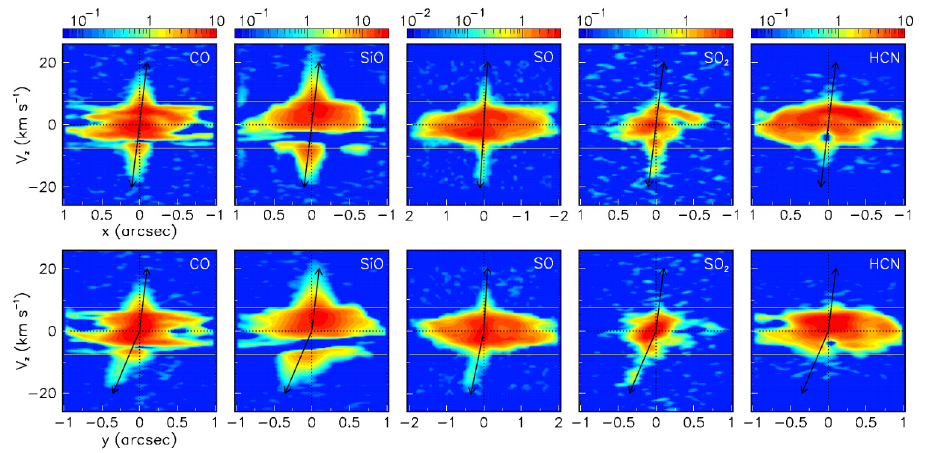
Figure 7 : R Dor: P-V maps in the V z vs x and vs y planes. The colour scale is in units of Jy arcsec − 1 . Yellow lines show the cuts applied in the definition of the large Doppler velocity